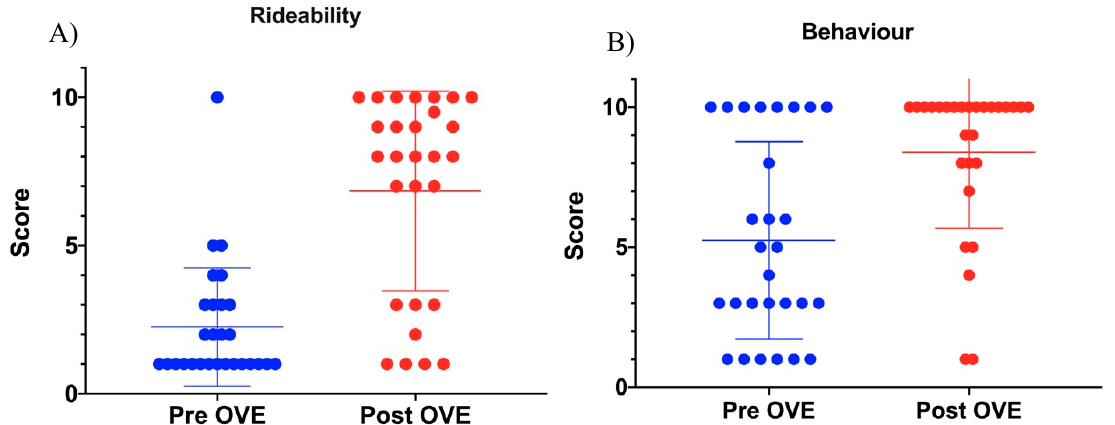
Figure 1. Comparison of ( A ) rideability and ( B ) behaviour pre- and post- ovariectomy (OVE). The score on the y -axis indicates the owners’ observation (1–10, with 10 being optimal rideability / behaviour). Each dot represents a case. Horizontal markers indicate the mean value and standard deviation.